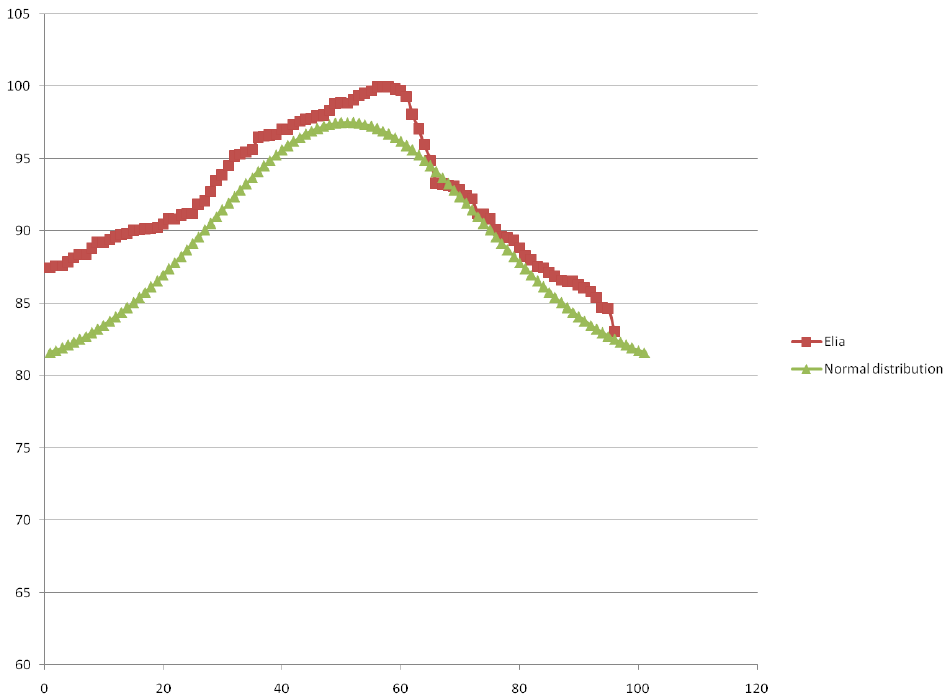
Figure 7. Normalized power load value distribution compared to the normal (or Gaussian) distribution for the given range of value—source: Elia Bruxelles,